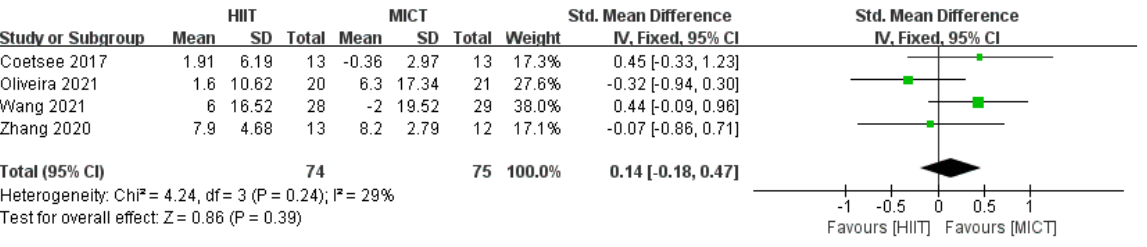
Figure 3. Effect of HIIT and MICT interventions on correct rate [24,25,34,36].